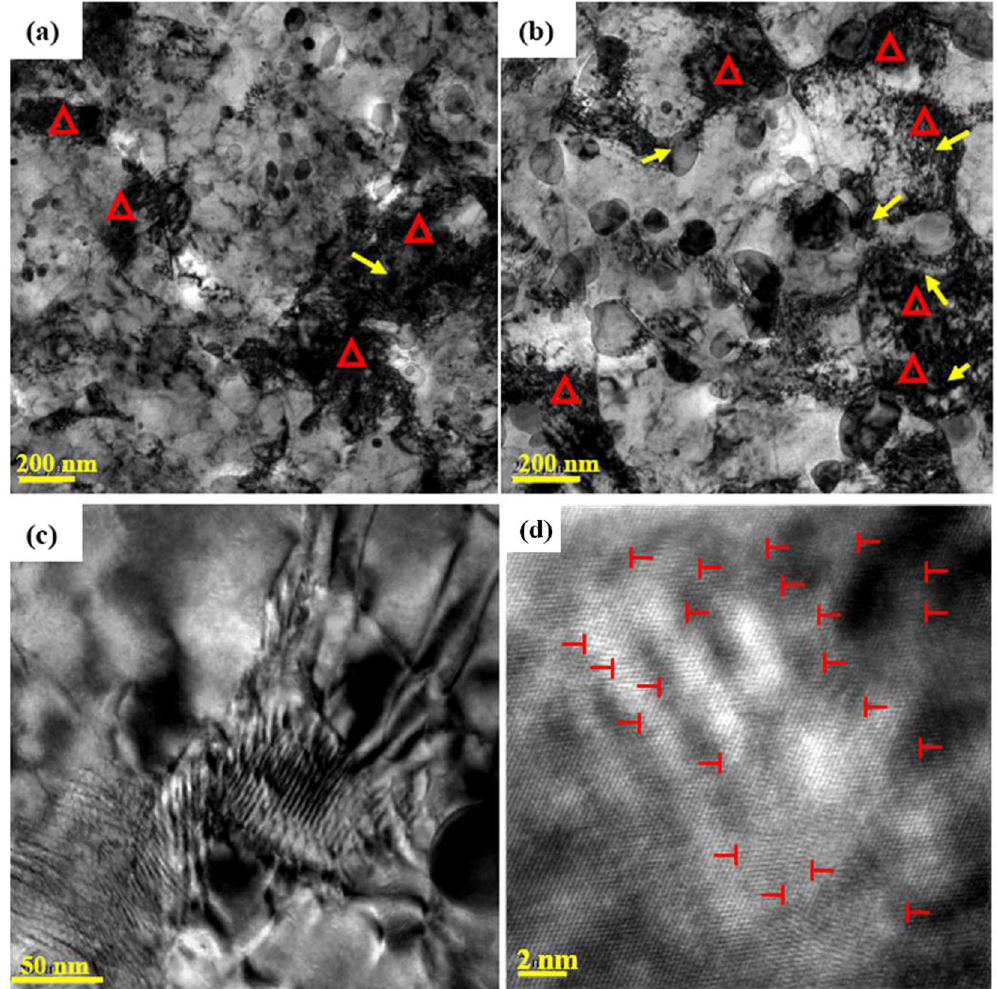
Figure 6. TEM micrographs showing morphology of ( a ) UFG-1 and ( b ) UFG-2 steels after tensile deformation. Some Fe 3 C particles and dense dislocations are indicated by arrows and triangles, respectively. ( c ) Close observation of UFG-2 steel shows dislocations that are accumulated at the edge of nanosized Fe 3 C particles. ( d ) The corresponding HRTEM image of a Fe 3 C particle showing numerous dislocations (indicated as ⊥ ) are blocked in the interior of the